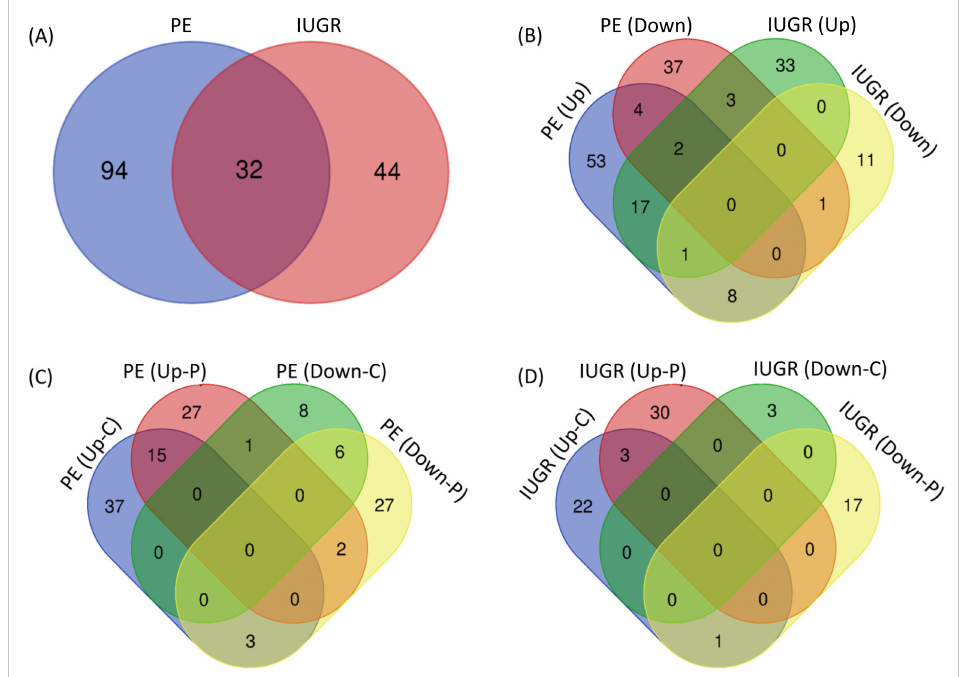
Figure 2. Comparison of total miRNAs linked to PE and IUGR ( A ), upregulated and downregulated miRNAs in PE and IUGR ( B ), different groups of miRNAs linked to PE ( C ), and different groups of miRNAs linked to IUGR ( D ). PE, preeclampsia; IUGR, intrauterine growth restriction; C, circulation; P,